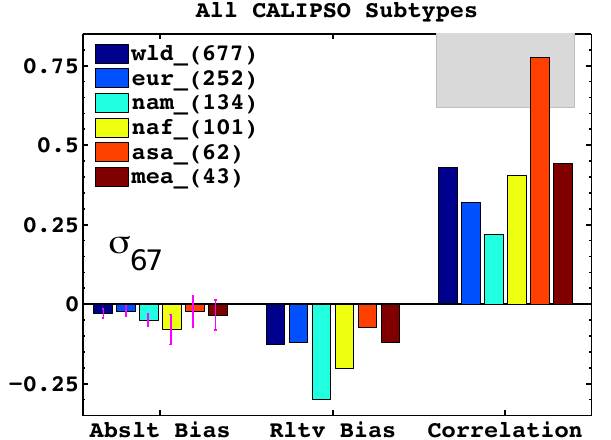
Fig. 6. Absolute bias ( B a ), relative bias ( B r ), and correlation co- efficient ( R ) for the four regions shown in Fig. 5 with the largest sample sizes (i.e., Europe, North Africa, North America, Asia, and the Middle East) and all seven regions (wld). Gray shaded area rep- resents range of 80-km aerosol autocorrelations measured by An- derson et al. (2003).